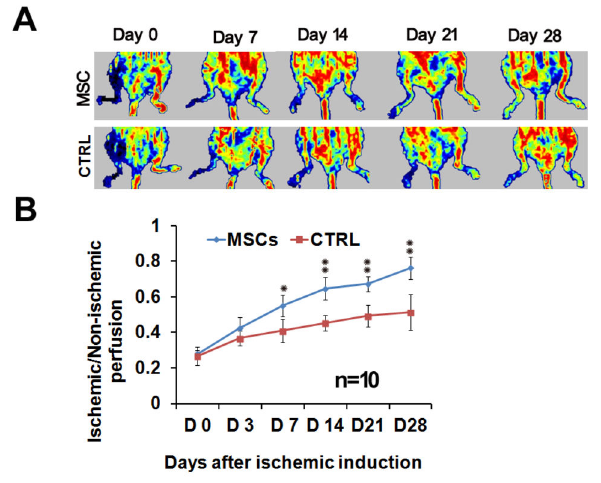
Figure 9. MSCs engraft into the ischemic hindlimb and restore perfusion. (A) The blood flow was assessed by laser Doppler perfusion imaging (LDPI) at days 0, 7, 14, 21 and 28 after surgery. Normal perfusion is displayed as red, while low or absent perfusion is displayed as dark blue. (B) LDPI results showed that blood flow in the ischemic hindlimb was decreased equally in both groups immediately after surgery (D0). Over the subsequent 28 days, blood perfusion of the ischemic hindlimb notably improved in the treatment group. At days 14, 21, and 28 the perfusion index is significant higher in the treatment group than control group. (٭٭P<0.01, * P<0.05).